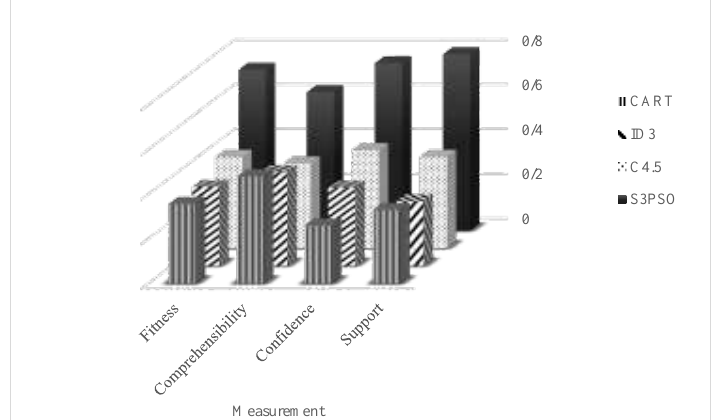
Figure 13. Results of Support, Confidence, Comprehensibility, and Fitness measurements for different methods on the used Moodle case study.